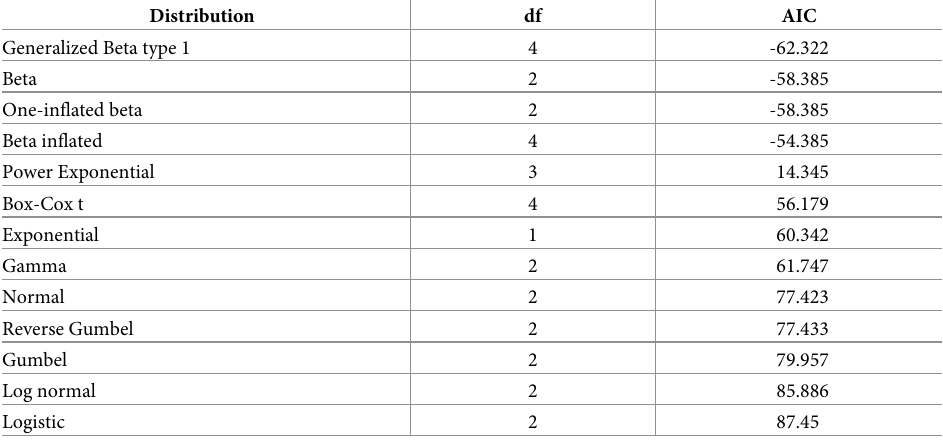
Table 1. Distribution fit test for Jacaranda flowering intensity. Lower Akaike Information Criterion values (AIC) and lower degrees of freedom (df) indicate the fit of the dataset to each